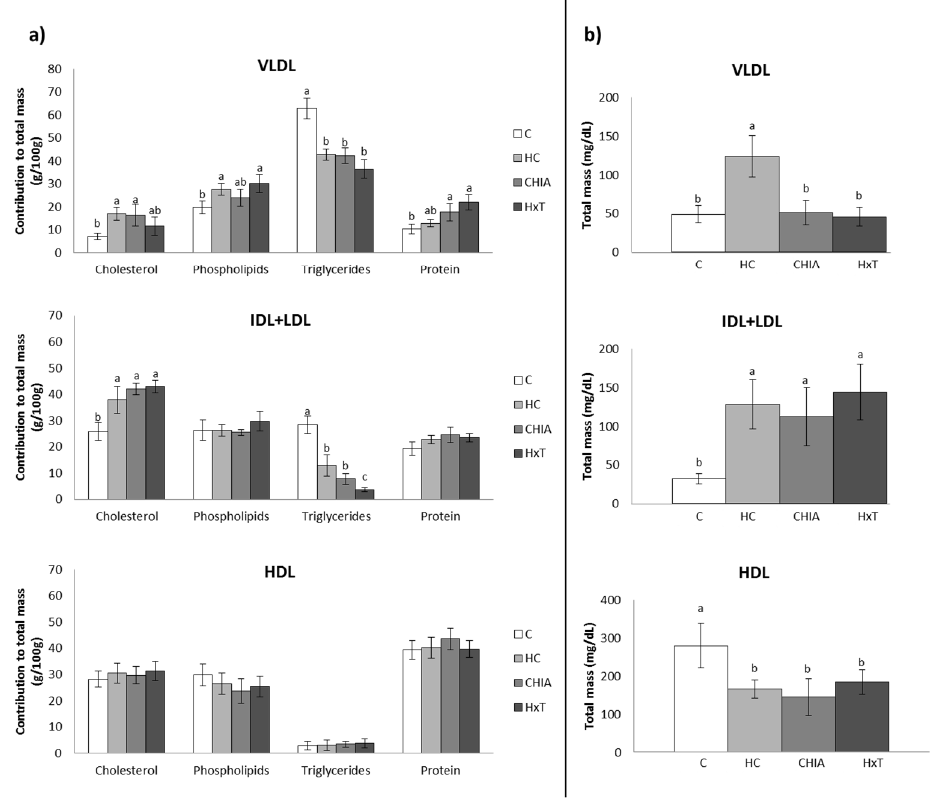
Figure 1. ( a ) Percentage of contribution of the different lipids and protein to the total mass of plasma VLDL, IDL + LDL and HDL. ( b ) Total mass (total lipids + protein) of the different lipoproteins. C, control-RP diet; HC, Cholesterol-enriched high-saturated/high-cholesterol control-RP diet; HxT, hydroxytyrosol-RP cholesterol-enriched high-saturated/high-cholesterol diet; CHIA, Chia oil-RP cholesterol-enriched high-saturated/high-cholesterol diet. VLDL, very low-density lipoproteins; IDL, intermediate-density lipoproteins; LDL, low-density lipoproteins; HDL, high-density lipoproteins. Bars, mean values ± SD, for a variable bearing different letters indicate significant differences between groups for each parameter ( p < 0.05; a > b > c) (one way ANOVA followed by the T2 Tamhane post-hoc test).